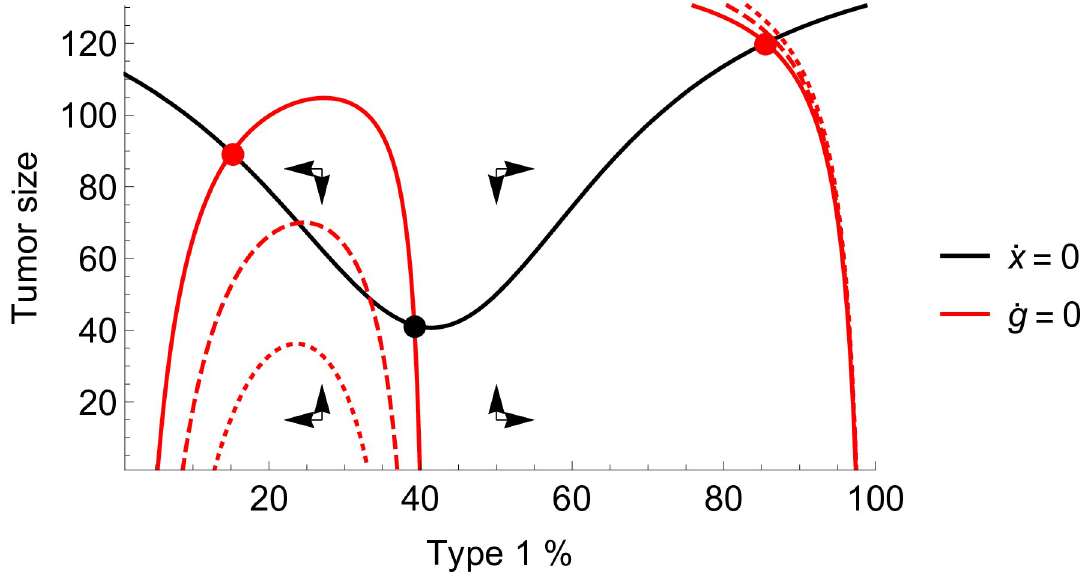
Fig 6. Zero-isoclines under mutation therapy. The effects of mutation therapy on the system’s phase diagram. Mutating type 2 cells to type 1 cells shrinks the former’s basin of attraction. A slight mutation therapy maintains two stable equilibria, one for each type (dashed red), a stronger one eliminates the type 2-dominated stable equilibrium (dotted red). Parameters: r 1 = 0.4, r 2 = 0.2, d 1 = d 2 = 0, K = 150, c